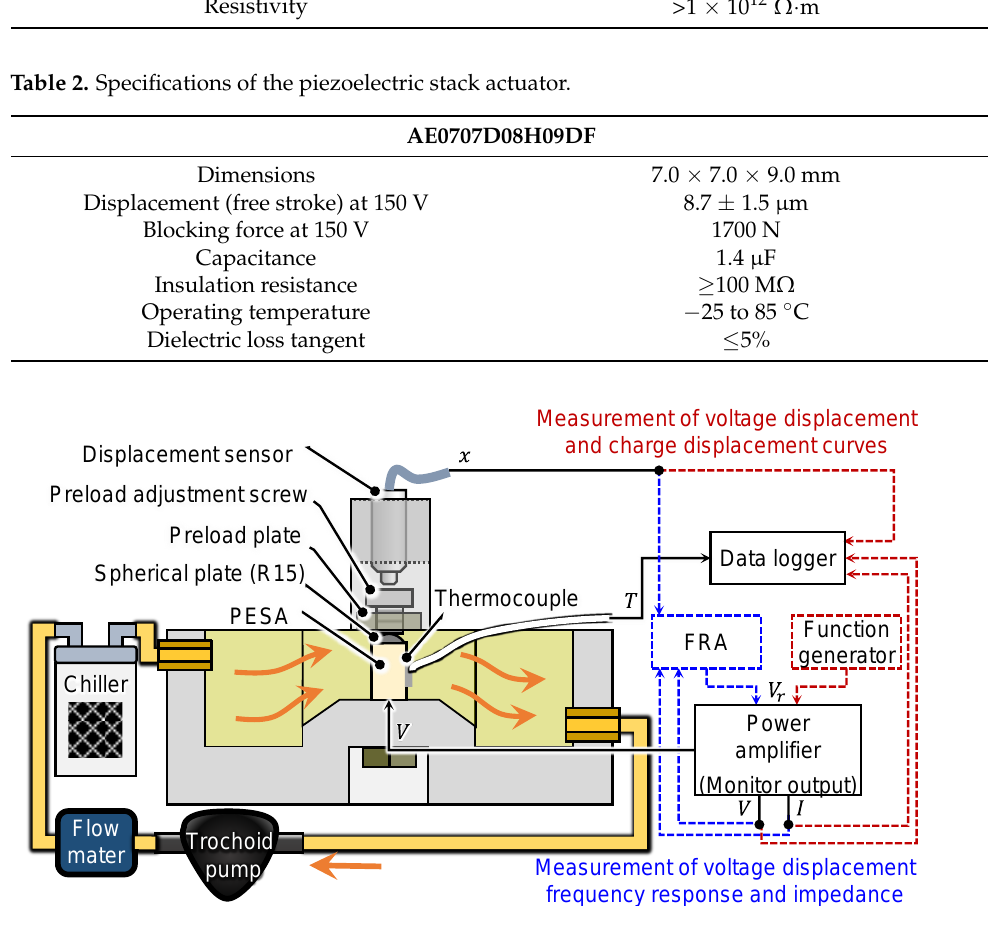
Figure 1. Experimental setup for forced liquid cooling of a PESA.